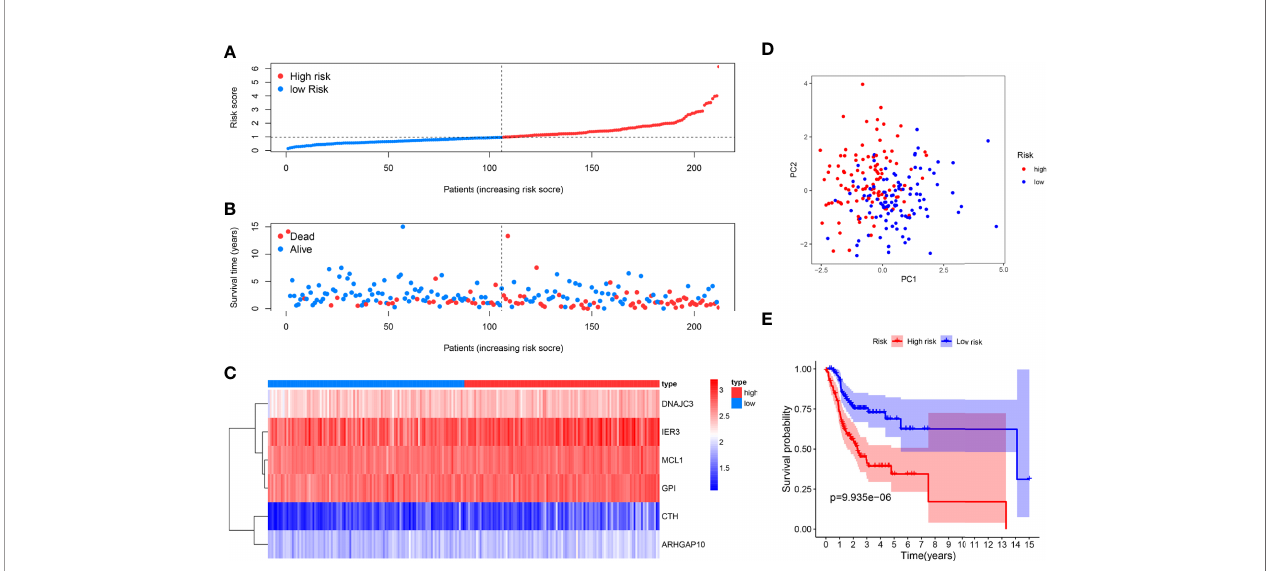
FIGURE 2 | Prognosis analysis of the internal training dataset. (A) The median risk score allocated OSCC patients in TCGA into two groups. From left to right, the risk scores were ascending and each dot represents an individual. (B) Patients with different survival times and statuses were arranged with the increasing risk score from left to right; clearly, the dead patients have higher risk score. (C) The heatmap showed expression pro fi le of the six risk genes. The expression level from high to low was manifested with the colors from red to blue. (D) The high- and low-risk groups were gathered in two directions through the PCA analysis. (E) Kaplan – Meier analysis showed different prognosis between the two